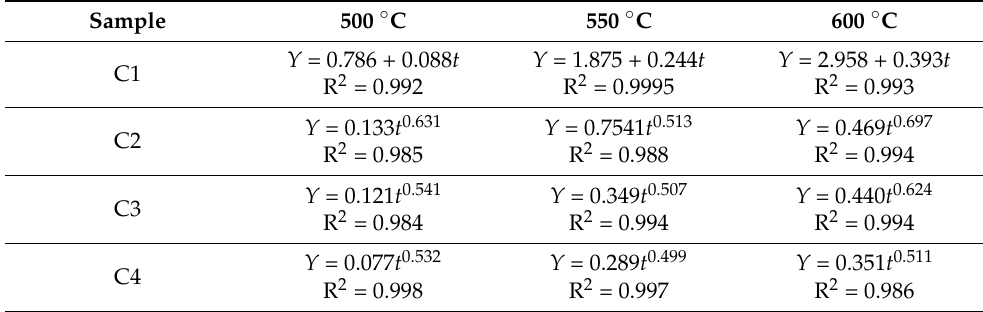
Table 7. Fitting curve parameters of high-temperature kinetics curves plotted in Figure